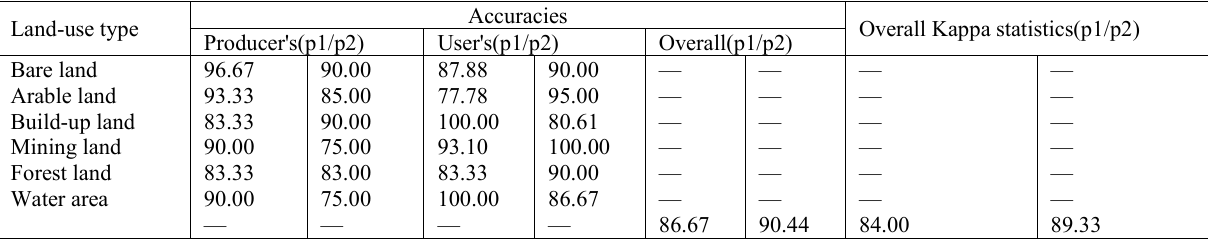
Table 3. Error matrices for both the land cover classification of Map 2012 (p1) and Map 2015 (p2) (%)